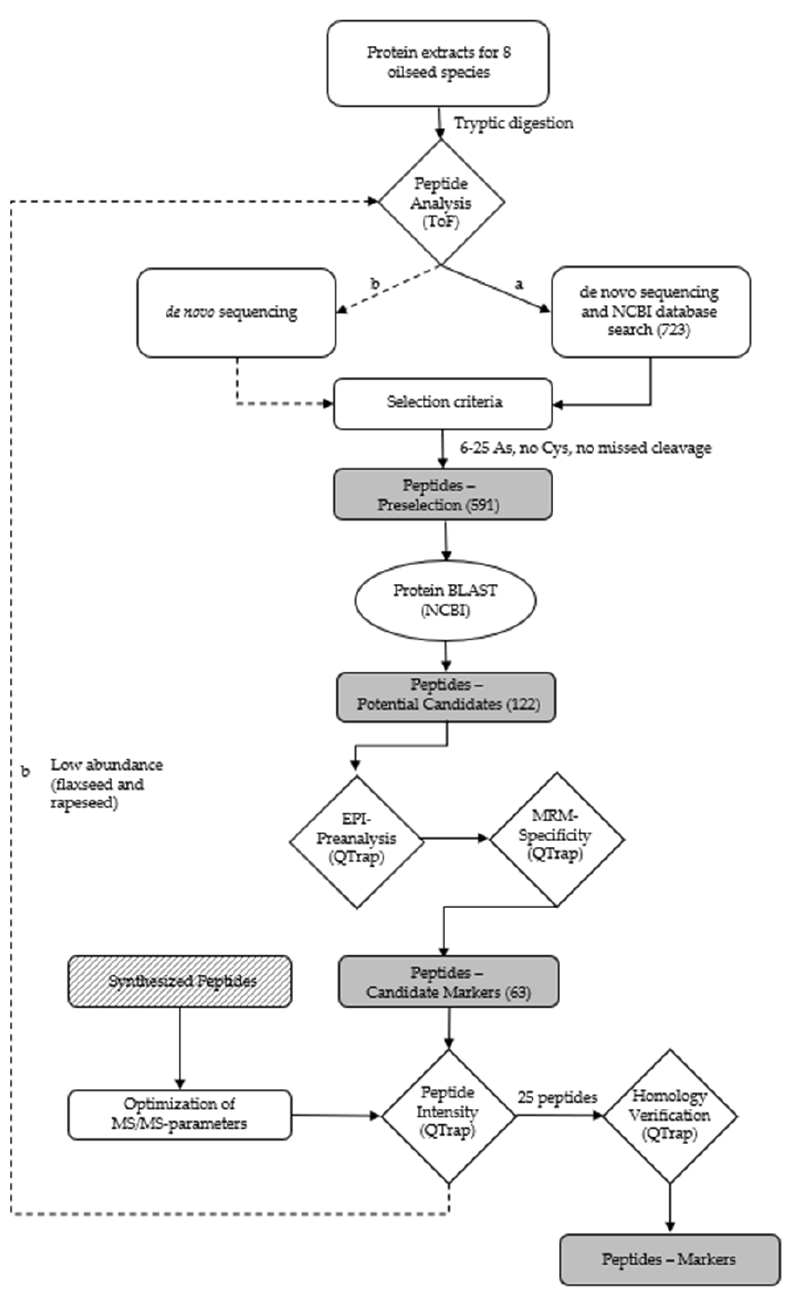
Figure 2. Workflow for the identification of (a) peptides for chia, coconut, flaxseed, hemp, pumpkin, rapeseed, sesame and sunflower via database search, and (b) de novo peptides for flaxseed and rapeseed due to the low abundance of peptides identified by (a).